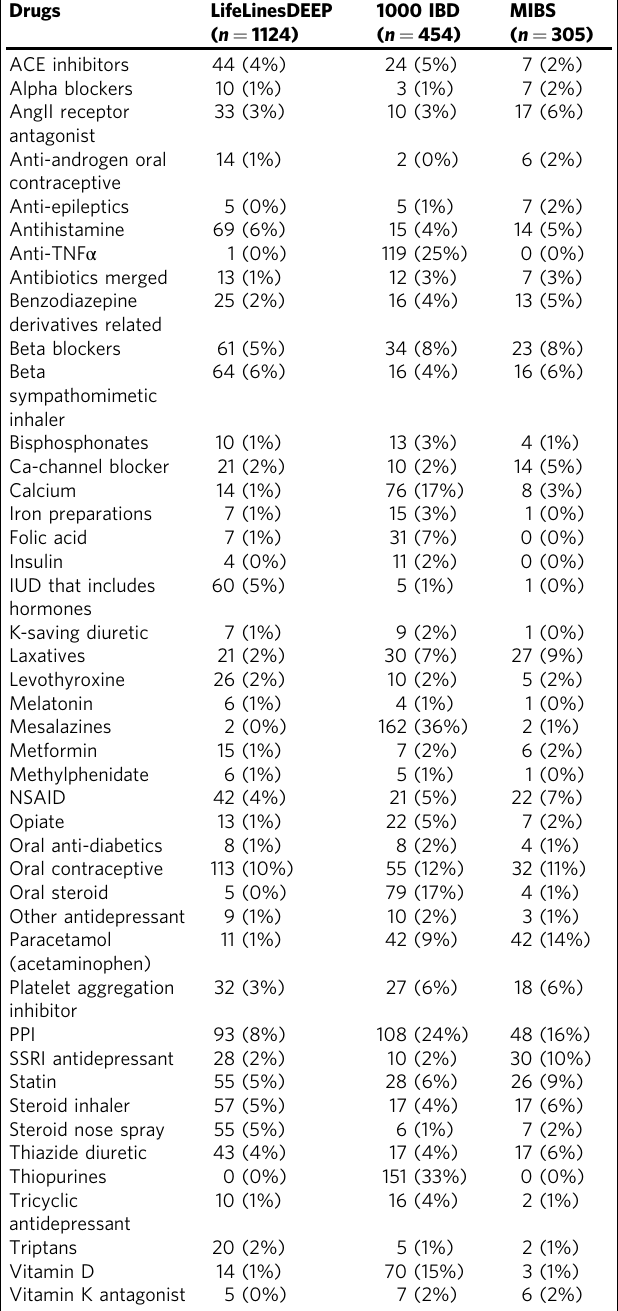
Table 1 Drug usage per cohort. Number and percentage of drug users in each